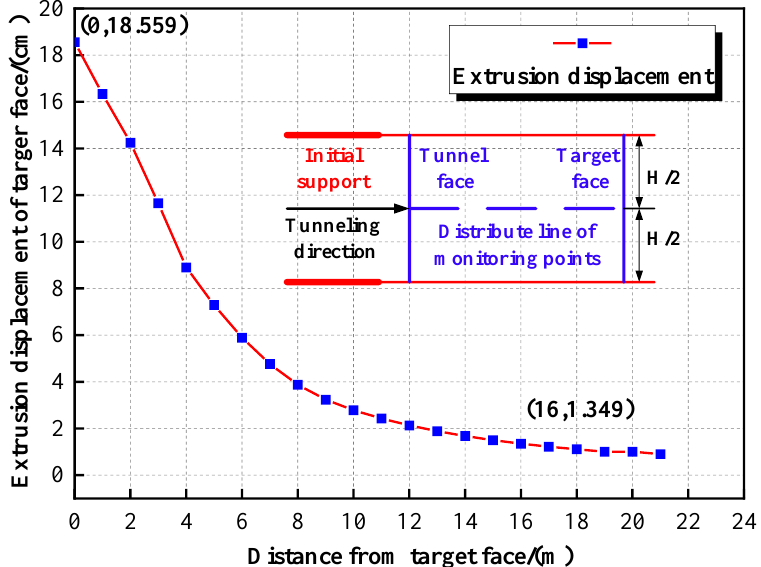
Figure 13. Extrusion displacement of the target face.